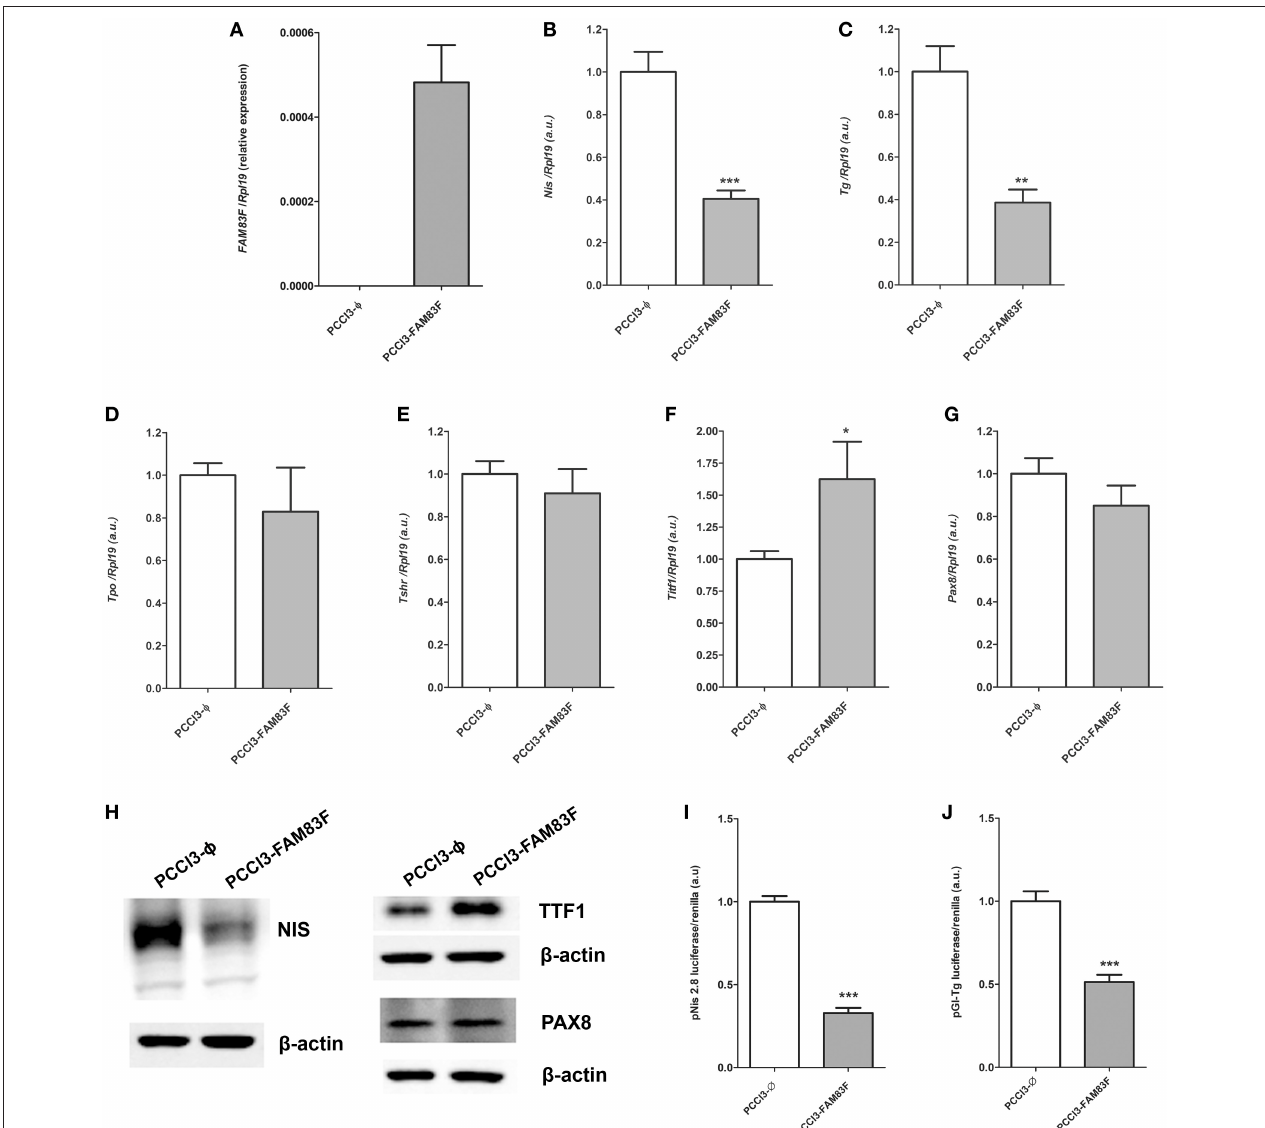
FIGURE 2 | FAM83F overexpression effects on thyroid differentiation genes of PCCL3 cell line. (A) Validation of FAM83F gene expression increase in PCCL3-FAM83F. In this case, data shown as relative expression due to undetectable levels of FAM83F in PCCL3- φ by qPCR; Expression levels of (B) Nis; (C) : Tg ; (D) Tpo ; (E) Tshr ; (F) Ttf1, and (G) Pax8 in PCCL3-FAM83F cells by qPCR. Data shown as mean ± SD of two independent experiments performed in triplicate normalized by PCCL3- φ . * P < 0.05, ** P < 0.01 and ** P < 0.001. (H) Protein expression of NIS, TTF1 (NKX2-1), and PAX8 analyzed by Western-blotting in PCCL3-FAM83F cells. (I) Transcriptional activity of Nis promoter measured after transfection of a reporter assay with pNis 2.8 luciferase plasmid; and (J) Tg promoter activity measured with pGl-Tg luciferase plasmid into PCCL3-FAM83F cells compared to PCCL3- φ . Data shown as mean ± SD of two independent experiments performed in triplicate. ** P < 0.01 and *** P <